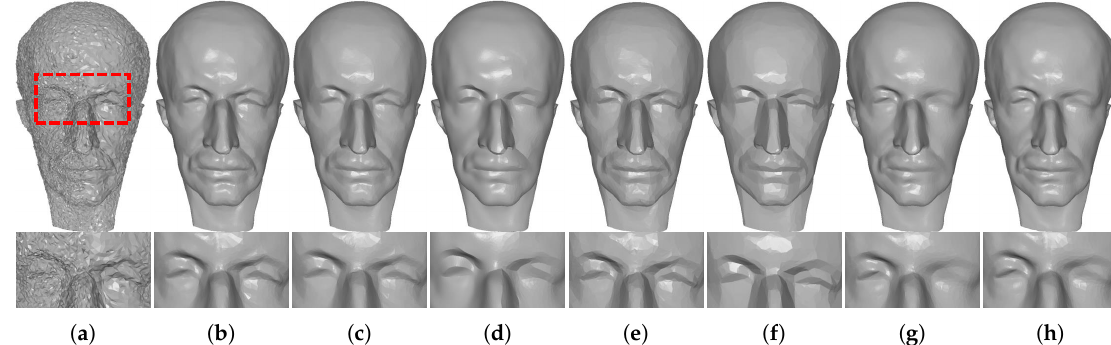
Figure 6. Denoising results of Max-Planck (corrupted by Gaussian noise, standard deviation = 0.2 mean edge length). From left to right: ( a ) noisy mesh, denoising results produced by ( b ) our method TS; ( c ) HO [1]; ( d ) RHM [14]; ( e ) TV [21]; ( f ) (cid:96) 0 [20]; ( g ) localBF [12]; and ( h ) globalBF [12], respectively. The second row shows the zoomed-in view.